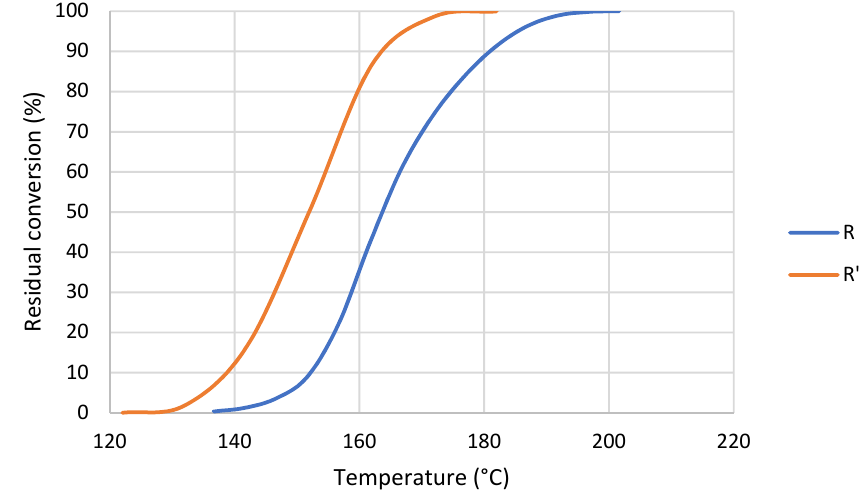
Figure 9. Conversion curves at 10 ◦ C/min of R and R’ after UV exposure.